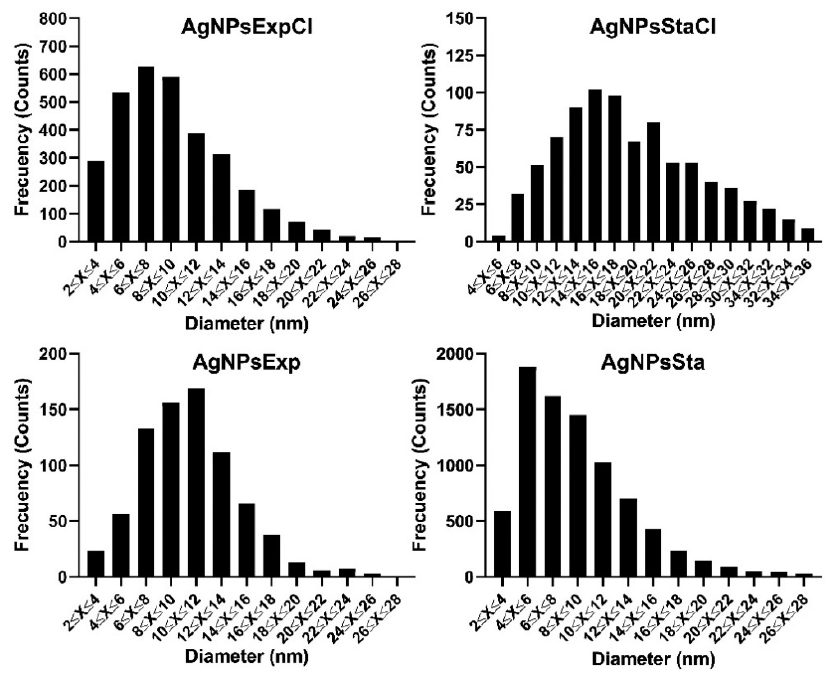
Figure 6. Distribution of AgNPs’ core diameters.